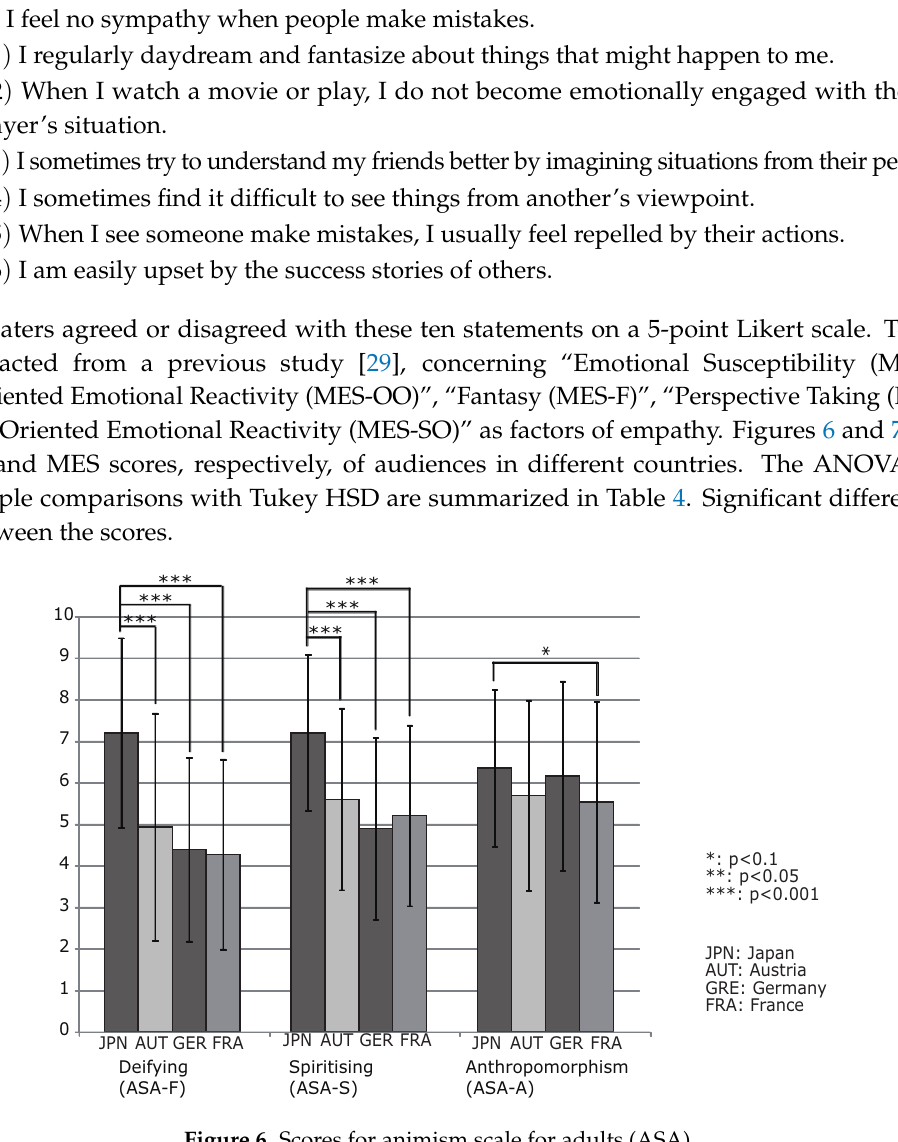
Figure 6. Scores for animism scale for adults